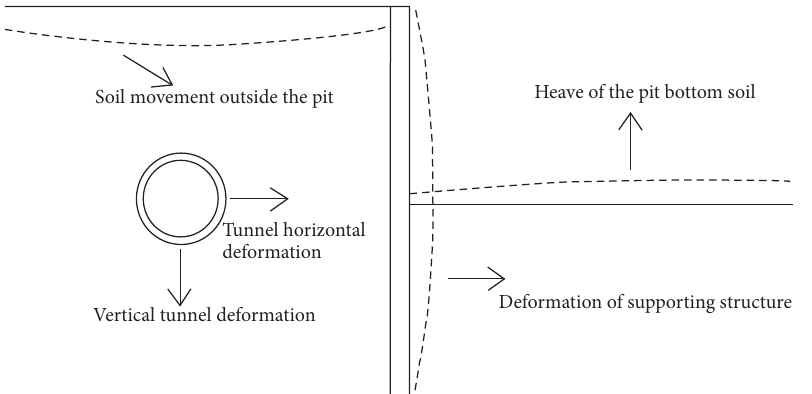
Figure 17: Diagram of deformation of subway tunnel